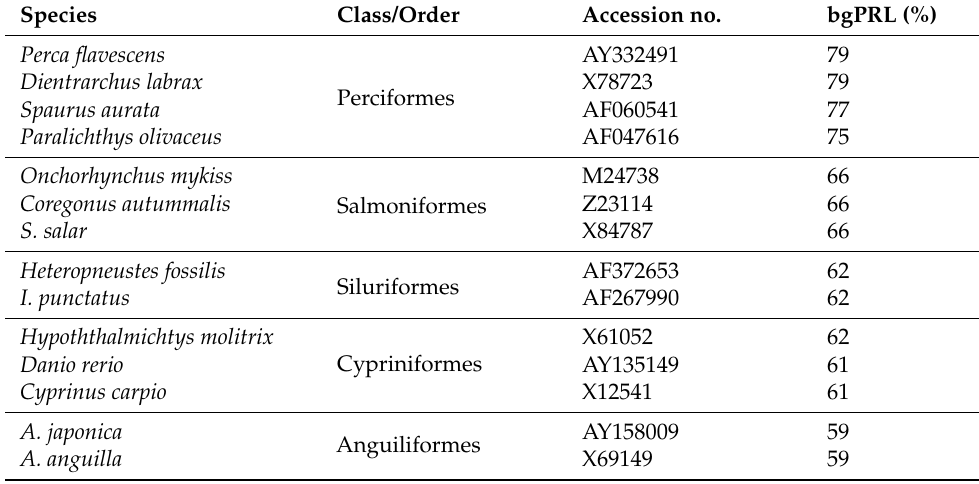
Table 2. Degree of homology between blue gourami (bp) PRL and PRL of other fish classes.